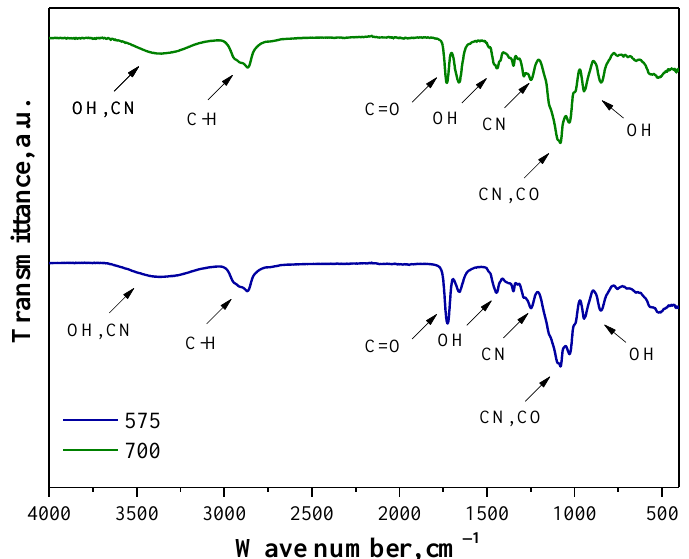
Figure 5. FT-IR spectra of polymer matrices obtained using crosslinker with average molecular weight 575 g/mol (blue) and 700 g/mol (green).